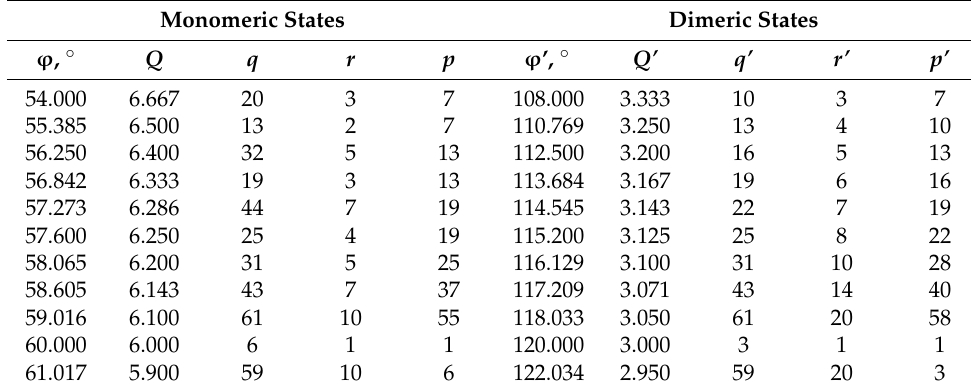
Table 1. Line symmetry group parameters used for